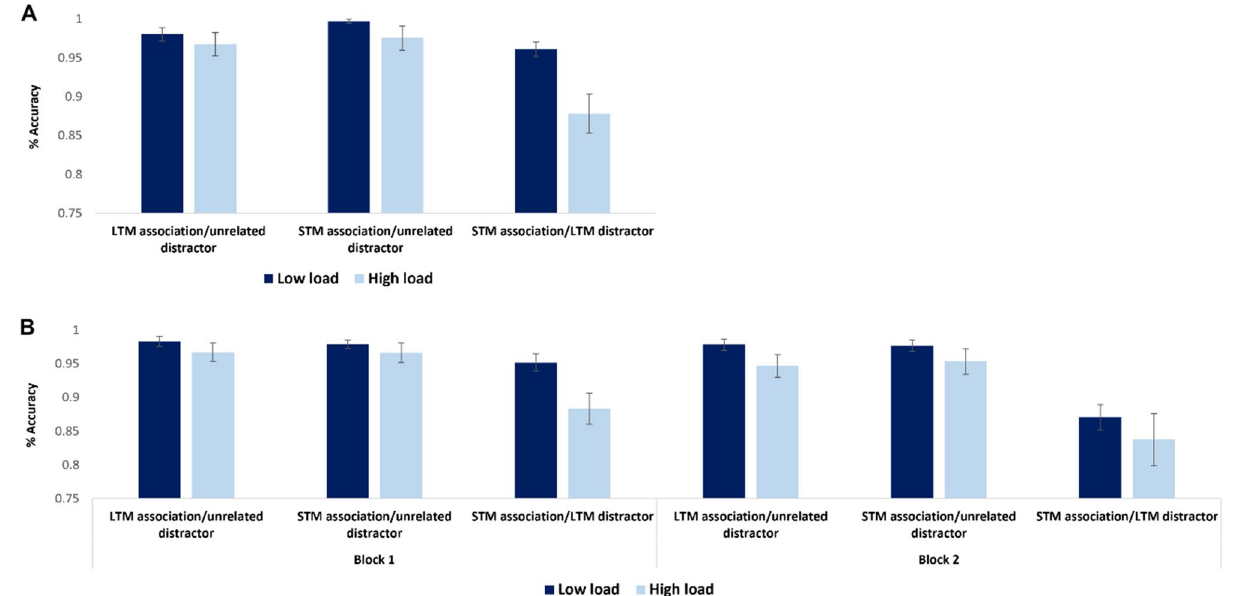
Figure 2. Results in Exp. 1a ( A ) and Exp. 1b ( B ). In each condition, left = target; right = distractor. ( A ) Main effect of load: p < .01, Main effect of recognition condition: p < .0009. Load X recognition condition Interaction: p < .009. ( B ) Main effect of load: p < .03, Main effect of block: p < .01, Main effect of recognition condition: p < .0009. Block X recognition condition Interaction: p < .007. Error bars indicate standard error of the